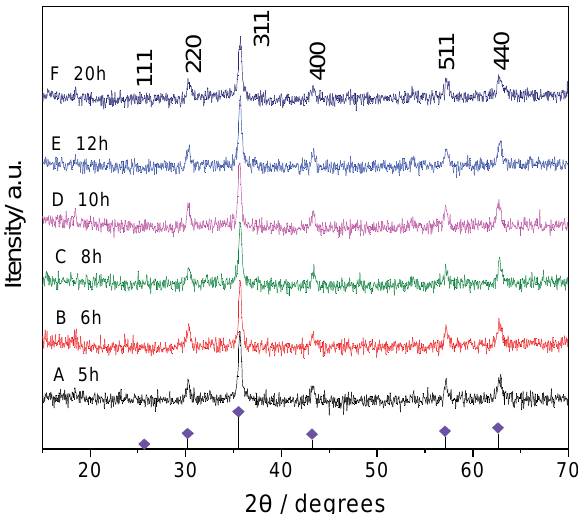
Figure 11. XRD patterns of Fe 3 O 4 obtained with different reaction time, 5 h; B: 6 h; C: 8 h; D: 10 h; E: 12 h; F: 20 h.